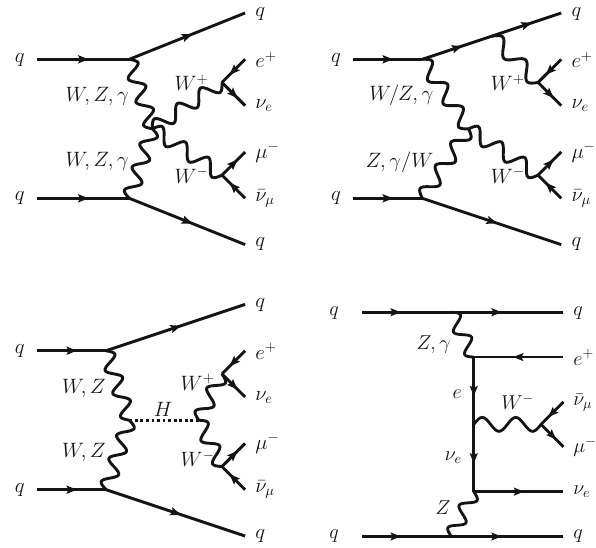
Fig. 1 Example Feynman diagrams for VBF- W + W − jj production at LO including leptonic decays and non-resonant contributions